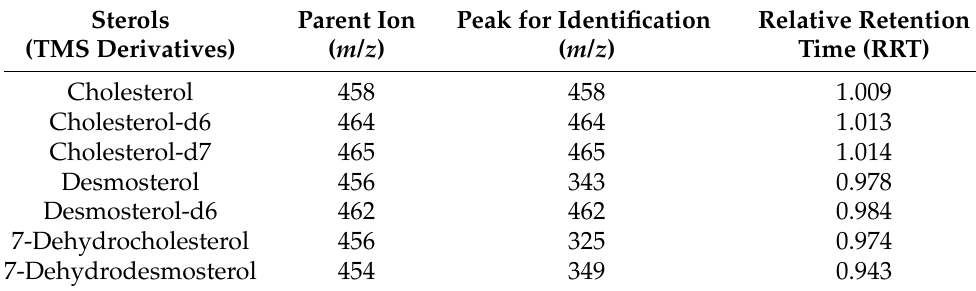
Table 1. List of sterols